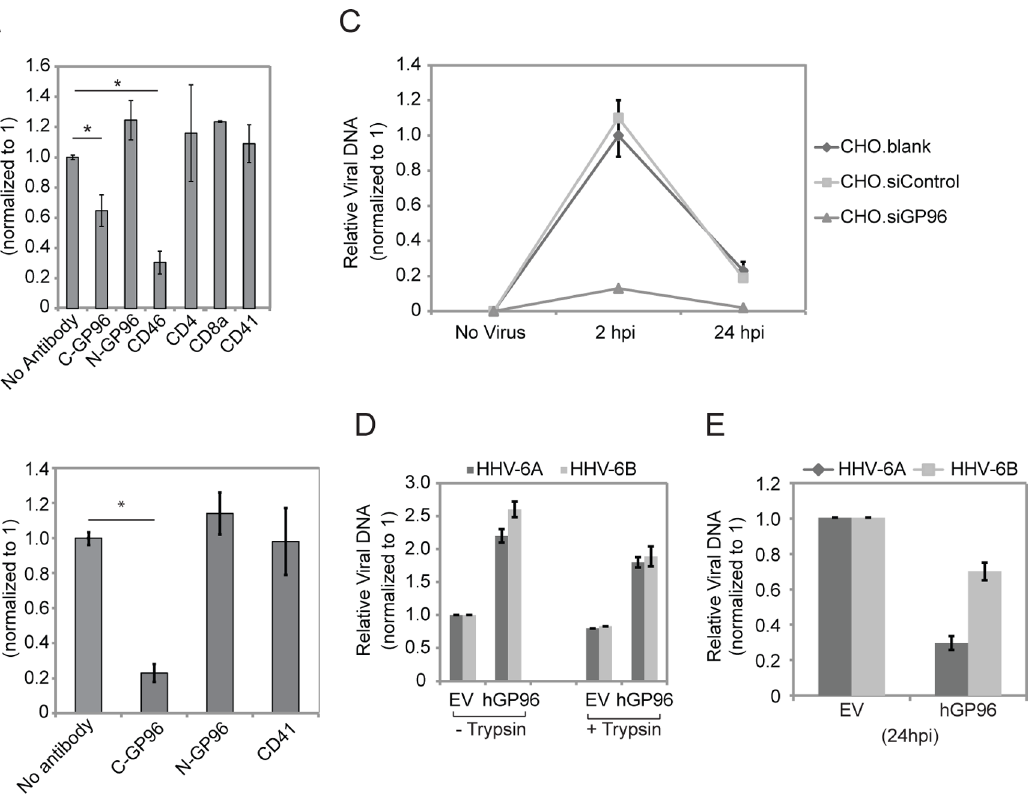
Figure 4. HHV-6 interacts with GP96. ( A ) Antibodies raised against the C-terminal end of GP96 prevent HHV-6A binding. HeLa cells were incubated with different antibodies for 30 min (used at 50 m g/ml) and then exposed to HHV-6 at the MOI of 1. After 1 h at 37 ˚ C, the cells were washed extensively and total DNA was extracted. The amount of viral particles bound to HeLa cells was measured by qPCR. Data represent the mean ¡ SEM of three independent experiments. *, p # 0.05. Statistical analysis was based on the Student t-test. ( B ) Similar experiments were performed in fresh PBMCs. Fresh PBMCs were isolated and stimulated with PHA for 2 days prior to the experiments. C-GP96, antibody raised against C-terminal of GP96; N-GP96, antibody raised against N-terminal of GP96. ( C ) Knock down of GP96 abolishes HHV-6 entry into CHO-K1 cells. CHO-K1 cells were transfected with siRNA against GP96 (siGP96). In parallel, cells were transfected with scrambled siRNAs (siControl) as a control. Blank transfected (CHO.blank) as well as siGP96 and siControl transfected cells were washed thoroughly and added with HHV-6A for 2 hrs after which cells were washed with trypsin for 3–5 minutes at 37 ˚ C followed by extensive washing with PBS to remove any unbound HHV-6 particles. Cells were then incubated for another 24 hrs in the absence of viral particle in the culture media and subsequently processed for quantification of viral DNA amount by qPCR. ( D ) Transient over-expression of human GP96 in CHO-K1 cells induces HHV-6 entry. CHO-K1 cells were transfected with a construct expressing human GP96 (hGp96). Empty vectors were transfected in parallel and were used as control. 48 h after transfection, cells were washed thoroughly and were infected with HHV-6A and -6B at an MOI of 10 for 2 h. A parallel set of infected cells was trypsinized to remove unbound viral DNA just before DNA extraction. Cells were washed extensively and total DNA was extracted. Viral DNA amount was quantified by qPCR. ( E ) Transient over-expression of human GP96 in CHO-K1 cells decreases HHV-6 survival. CHO-K1 cells were transfected with a construct expressing human GP96 (hGp96). Empty vectors were transfected in parallel and were used as control. 48 h after transfection, cells were washed thoroughly and were infected with HHV-6A and -6B at an MOI of 10 for 2 hrs and were processed as mentioned above. Viral DNA amount was quantified by